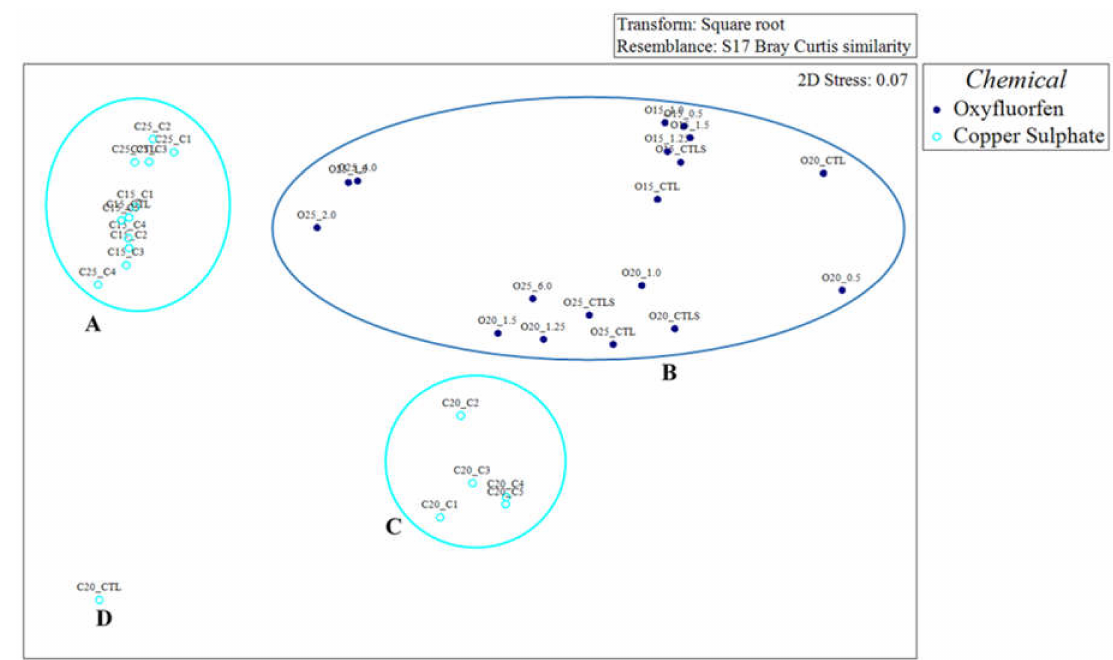
Figure 7. Two-dimensional non-metric MDS ordination plot of the polysaccharide content of T. weissflogii exposed to both contaminants at the three temperatures (15 ◦ C, 20 ◦ C, and 25 ◦ C). Empty circles represent the organisms exposed to copper sulfate (Groups A, C, and D), and the full gray circles represent the organisms exposed to oxyfluorfen (Group